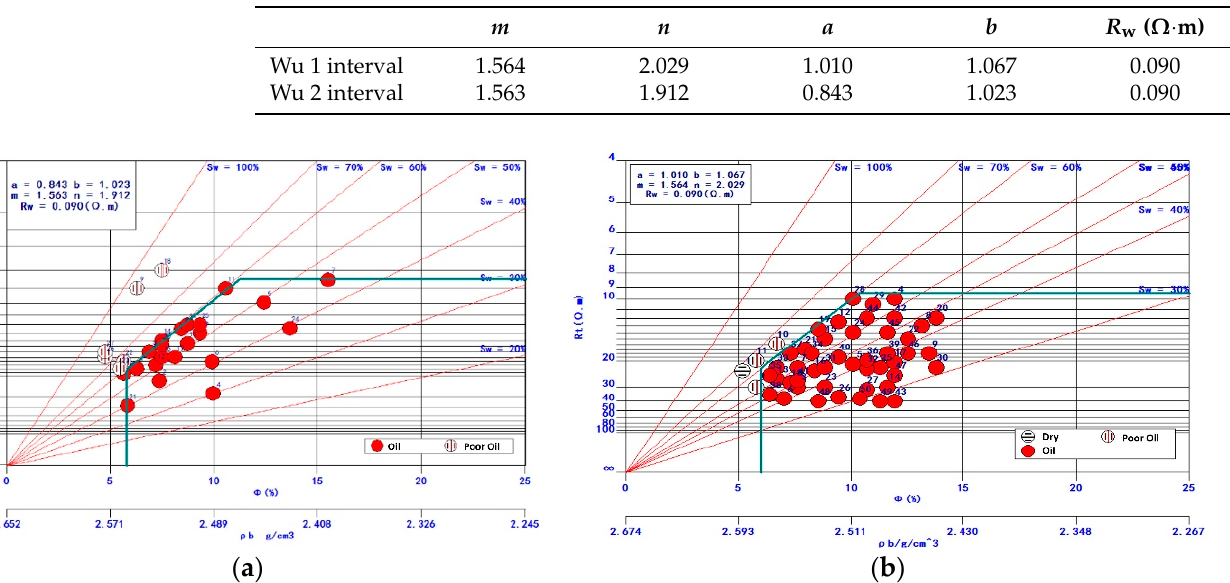
12 of 17 Figure 10. Comparisons between logging interpretation results and core analysis results: ( a ) clay content; ( b ) water saturation; ( c ) porosity. Figure 11. The distribution of clay content after correction. 4.2. Reservoir Interpretation